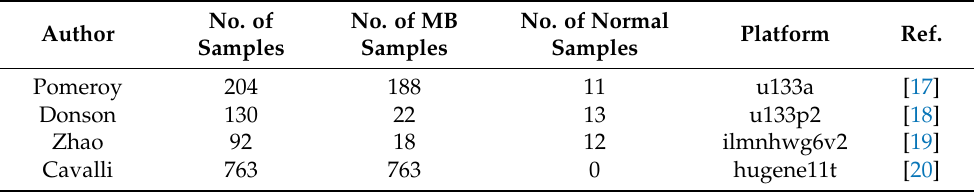
Table 1. A brief description of the four datasets used for this